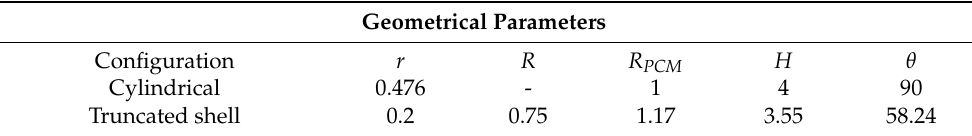
Table 2. The different parameters of the MH tanks.